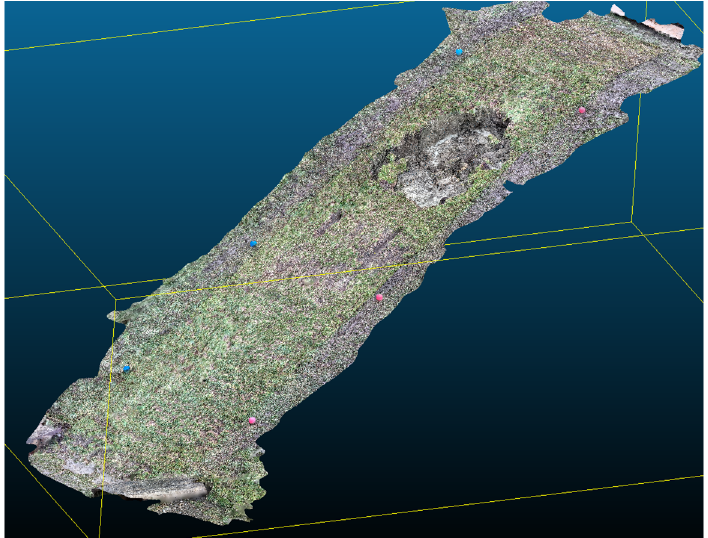
Figure 11. Example of a 3D view of the Handheld Lidar point cloud data of a damaged section.